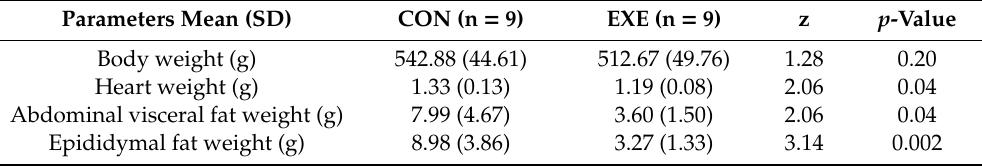
Table 1. Comparison of characteristics between the control and exercise group.